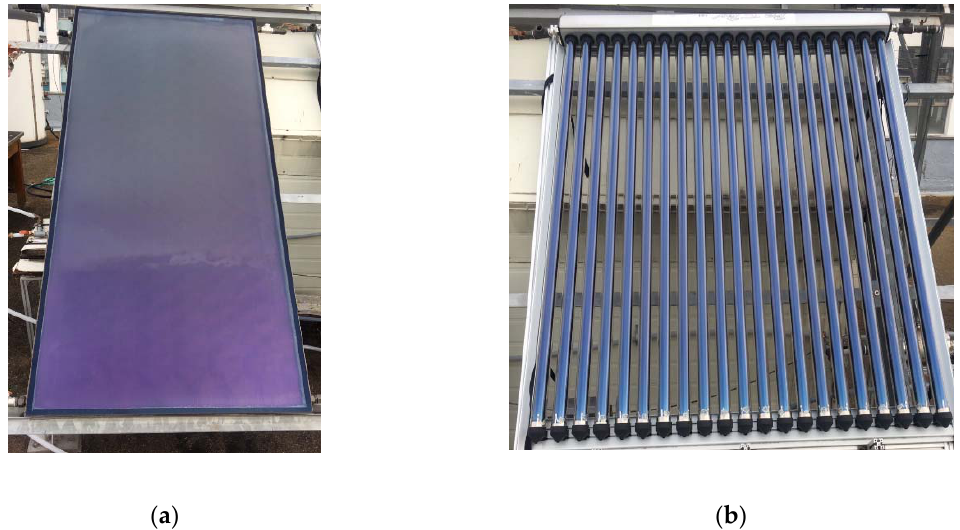
Figure 1. The flat plate and vacuum tube solar collectors used in this study. ( a ) Flat plate solar collector; ( b ) Vacuum tube solar collector.